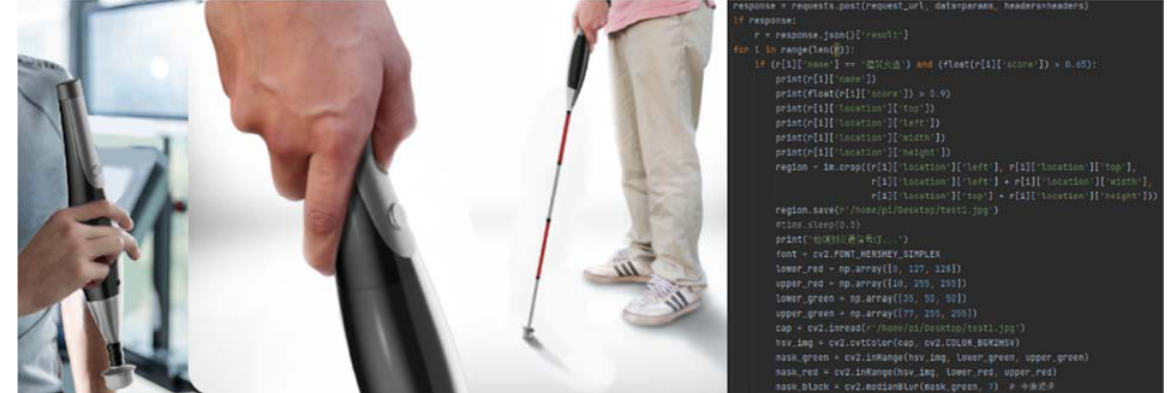
Figure 1. The logic diagrams of identifying the traffic lights and the text content.